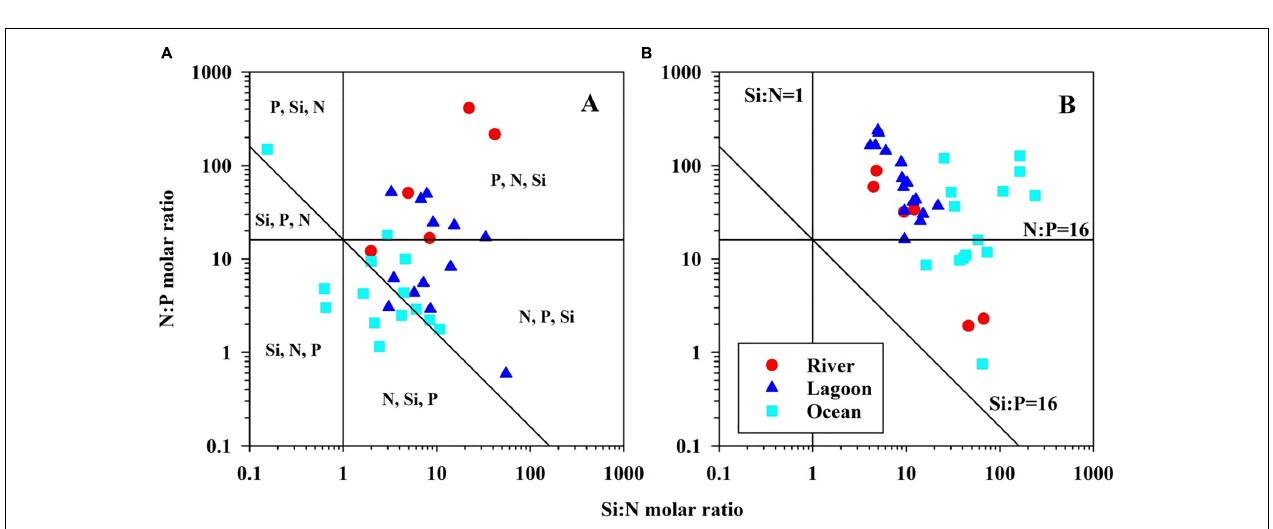
FIGURE 4 | Results from the principal component analysis (PCA) analysis, showing the principal components 1 and 2 for hydrographic parameters and sampling locations in dry season (A) and wet season (B) in Negombo lagoon from 2019 to 2020.